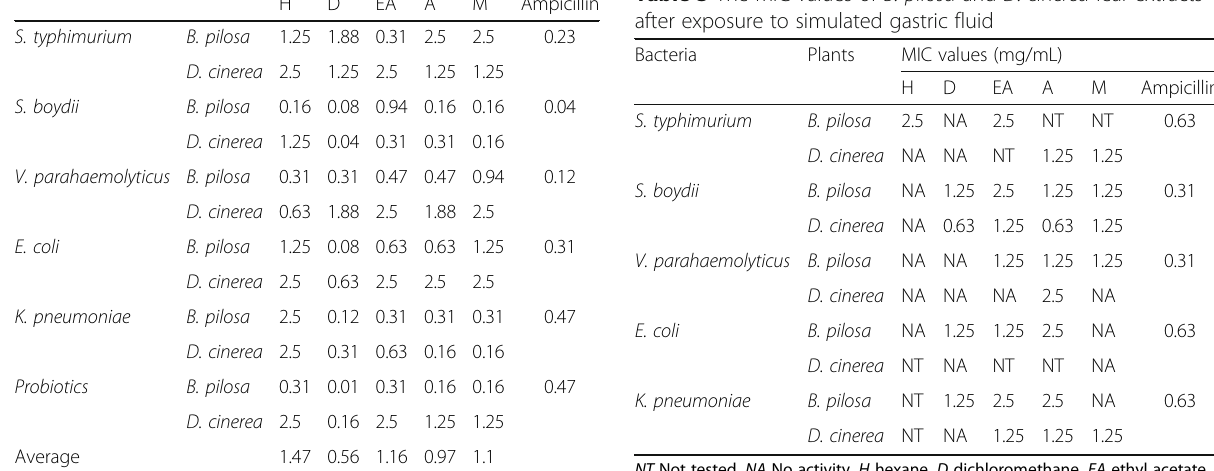
Table 2 The MIC values of B. pilosa and D. cinerea leaf extracts against selected microorganisms Bacteria